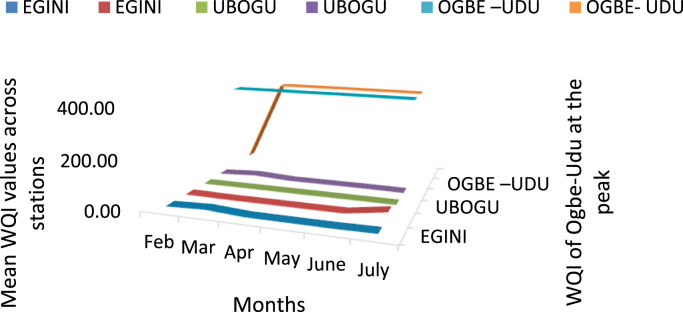
Spatial and monthly variations of WQI of Egini, Ugbogu, Rivers Delta state.